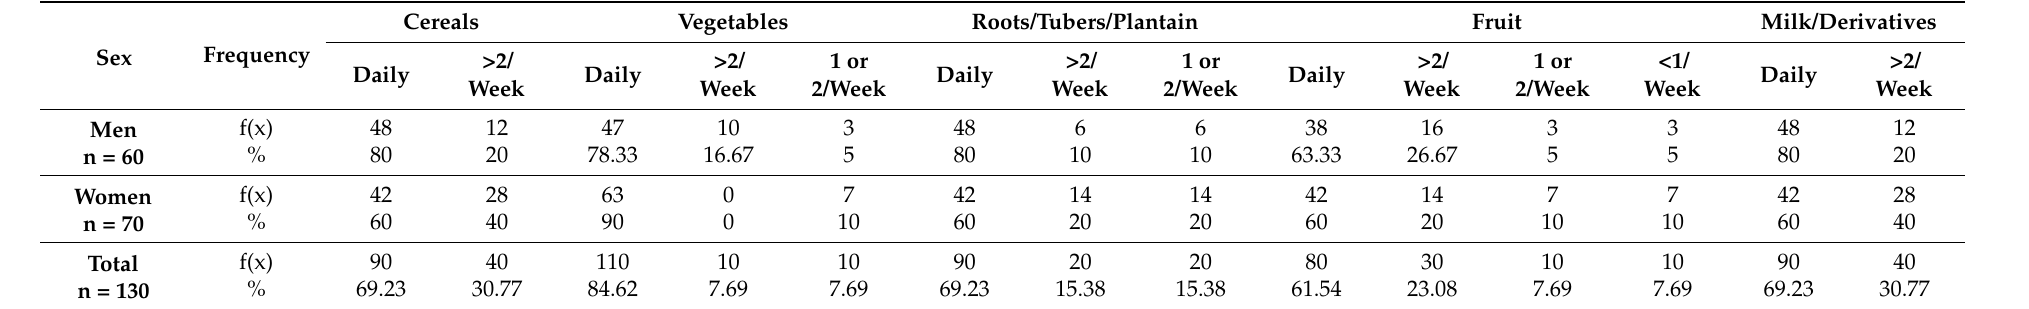
Table 3. Consumption frequency of food groups according to food intake. Classification in accordance with dietary recommendations for older adults. Daily consumed foods.